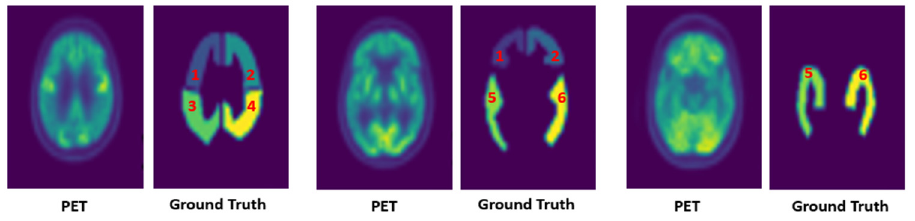
Figure 1. PET image ( left ) and manual segmentation ( right ) from three representative slices: right frontal lobe (label 1), left frontal lobe (label 2), right parietal lobe (label 3), left parietal lobe (label 4), right temporal lobe (label 5), and left temporal lobe (label 6).